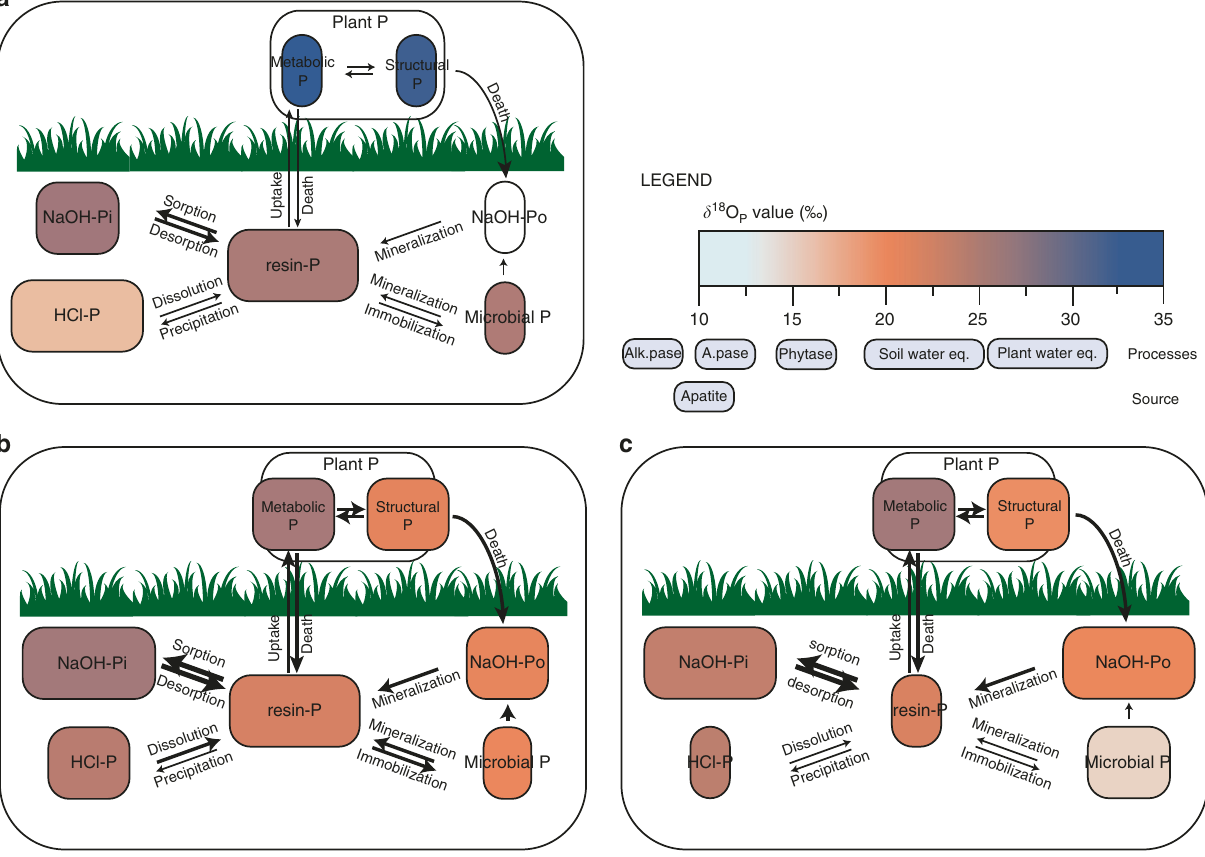
Fig. 5 Phosphorus cycling in three different climatic zones. For each climatic zone, arid ( a ), subhumid ( b ), and humid ( c ), the size of boxes represents the relative size of the pool and the size of arrows represents the relative importance of the respective fl ux. Pool colors correspond to δ 18 O P values. We assumed four process signals: fi rst, weathering of primary apatite with a δ 18 O P of 10 ‰ ; second, equilibration with water by pyrophosphatase in soil microbes (18 – 25 ‰ ); third, mineralization of organic P by hydrolyzing enzymes (7 – 17 ‰ , depending on the enzyme), and fourth release of plant P (23 – 35 ‰ ) (Supplementary Tables 4 and 5). At arid sites, δ 18 O P of soil NaOH-Po could not be measured due to small